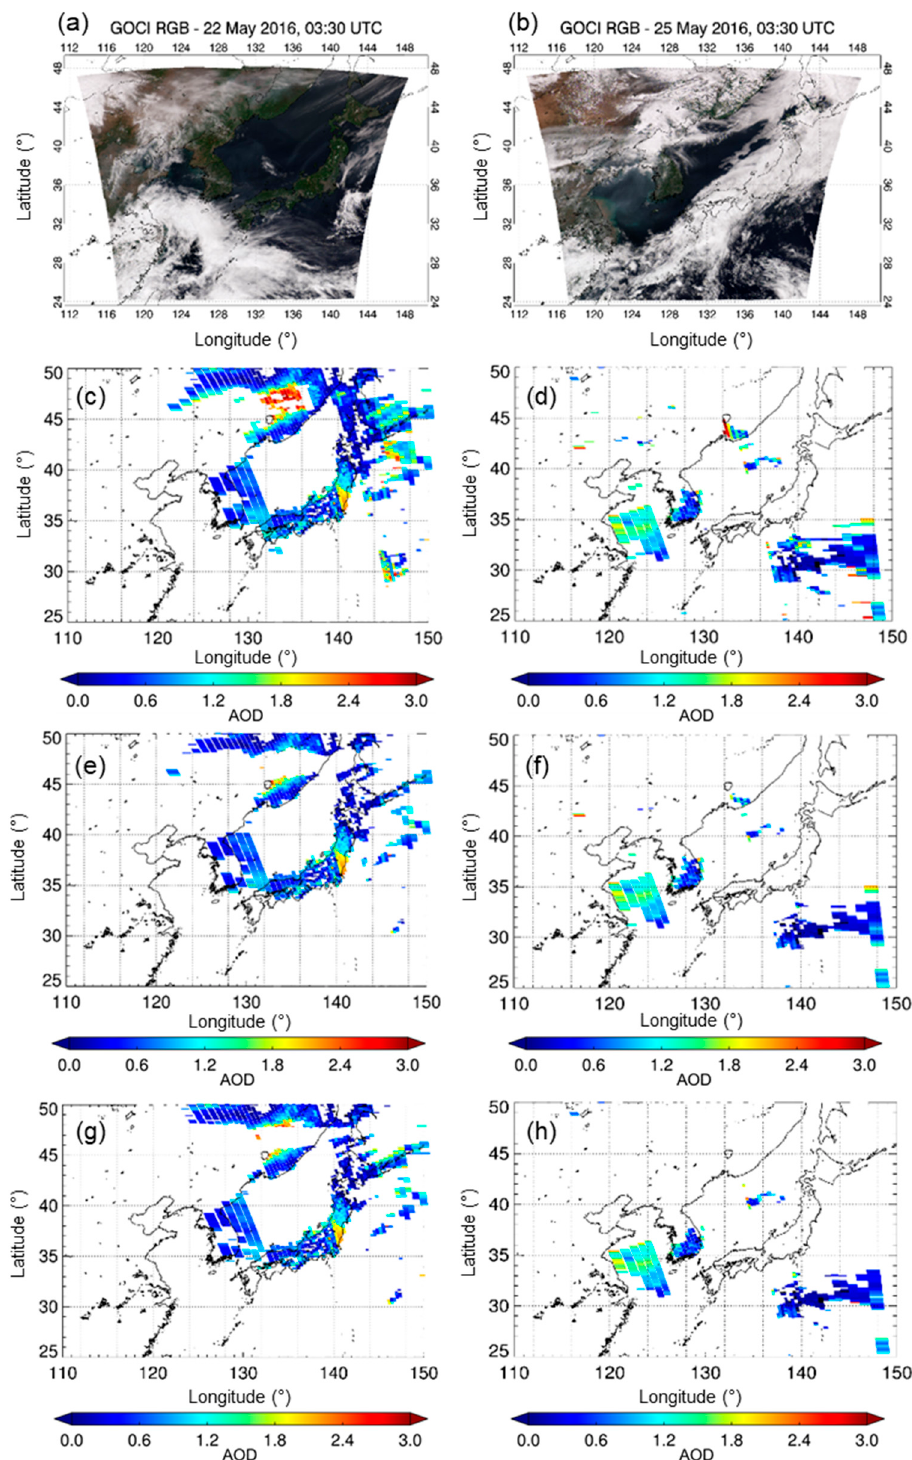
Figure 3. Case study of the synergistic use of meteorological imager (MI) for cloud masking on 22 May ( a , c , e , g ) and 25 May 2016 ( b , d , f , h ); with ( a , c , e , g ) representing cirrus cloud cases and ( b , d , f , h ) clear-sky cases. ( a , b ) represent the GOCI red–green–blue (RGB) image; ( c , d ) GEMS AOD retrieved with Ozone Monitoring Instrument (OMI) Level 1B (L1B) data; ( e , f ) retrieved GEMS AOD with synergistic use of Moderate-Resolution Imaging Spectroradiometer (MODIS) cloud-mask data (500 m); and ( g , h ) retrieved GEMS AOD with synergistic use of the Advanced Himawari Imager (AHI) cloud mask on 22 May and 25 May 2016, respectively.